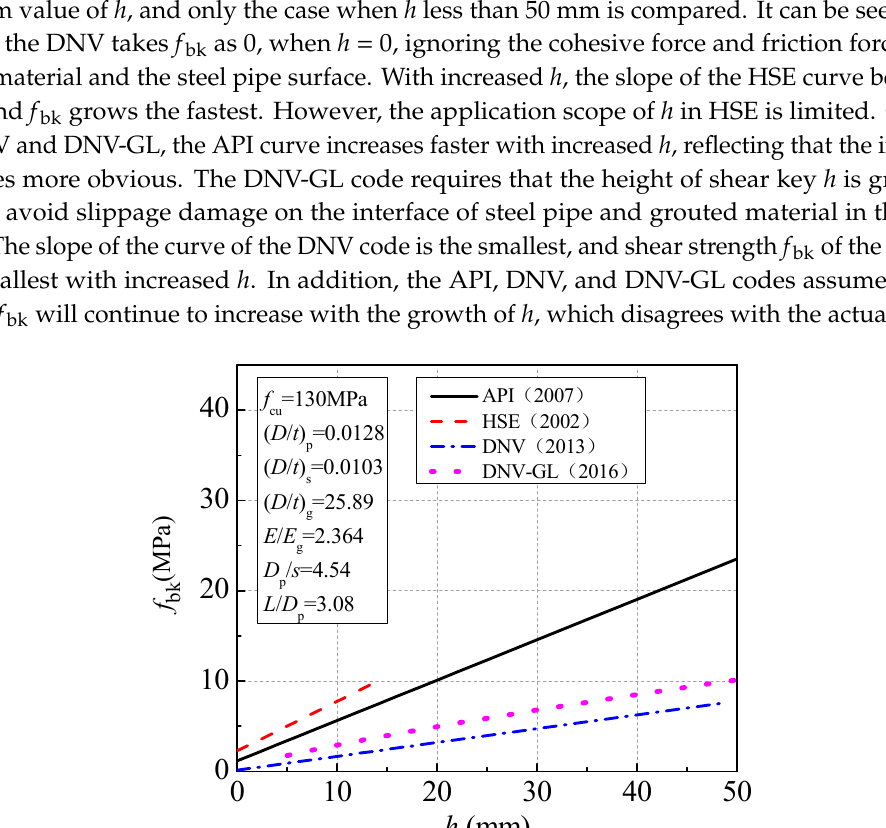
h / s Figure 4. Relationship between interface shear strength ( f bk ) and height-to-distance ratio of shear key ( h / s ).